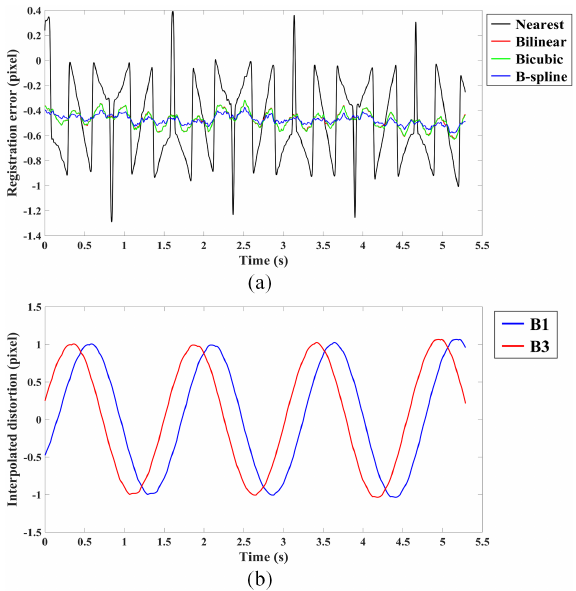
Figure 7. a) The registration errors between the compensated bands using different interpolators and b) the interpolated distortions on two bands in the cross-track